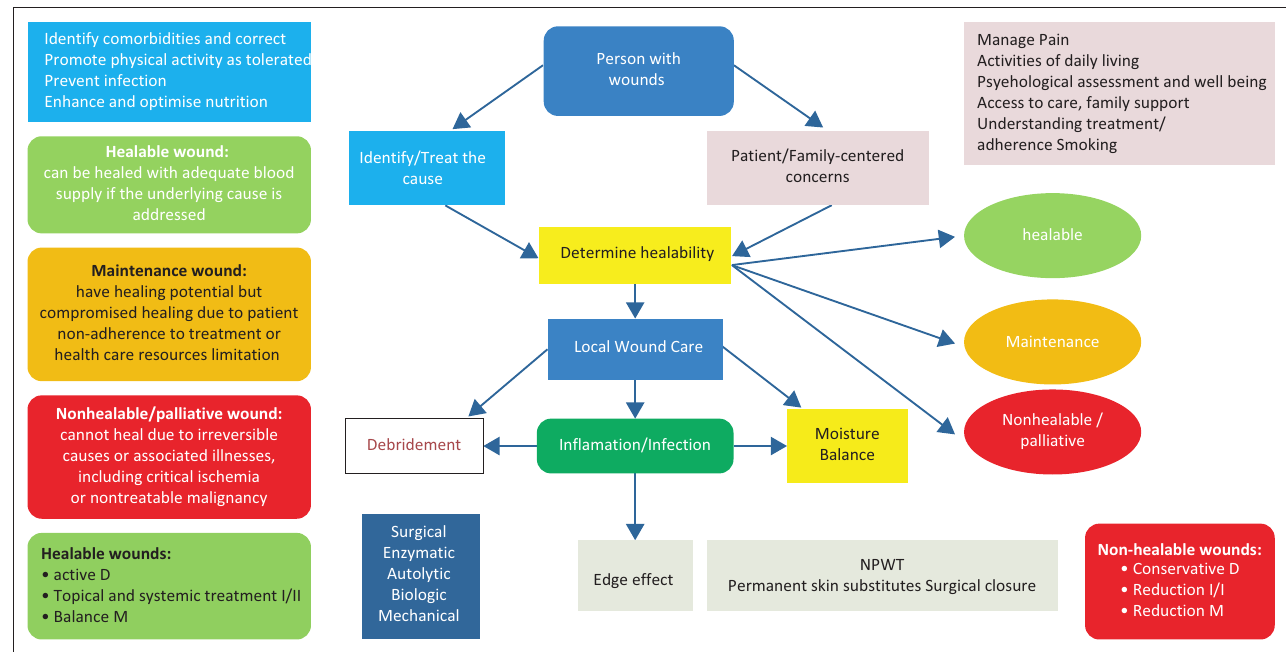
Identify comorbidities and correct Promote physical activity as